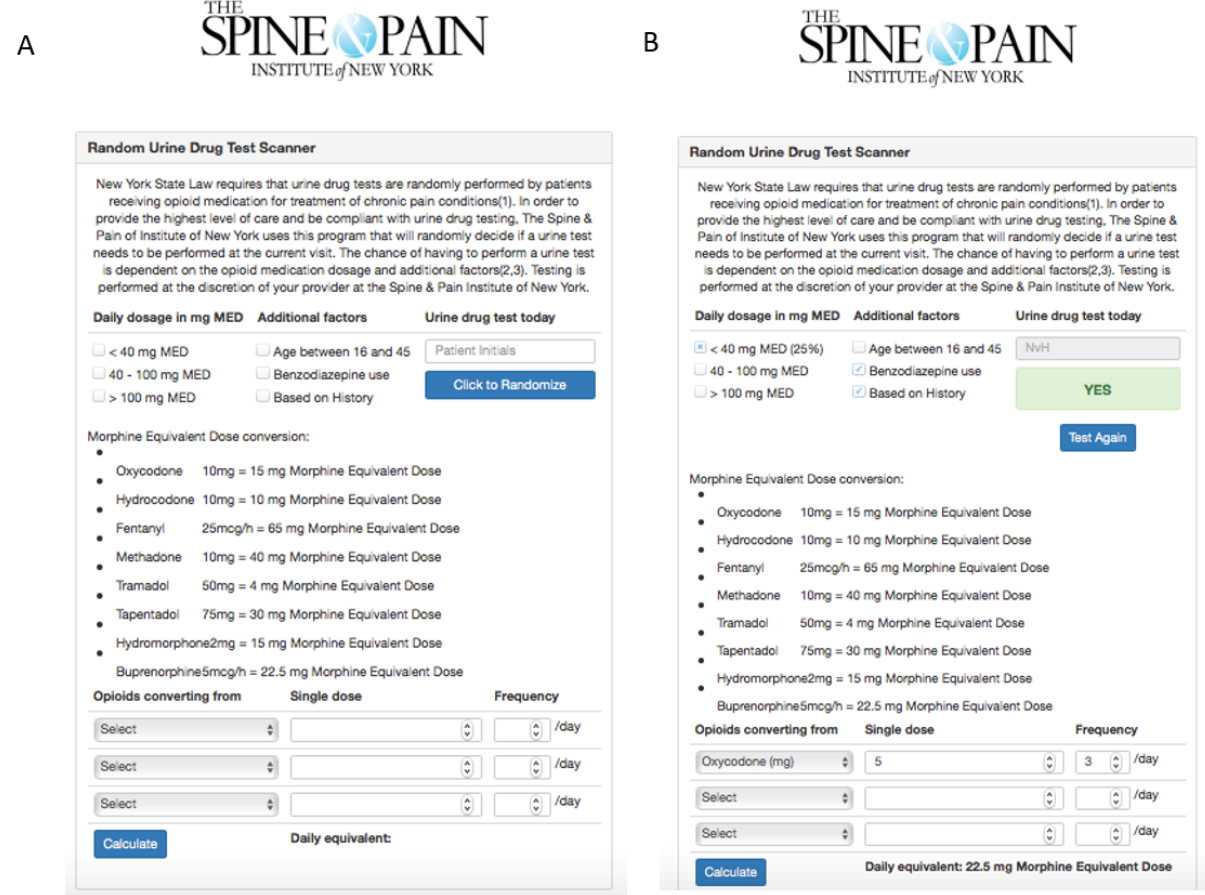
Figure 1. Screenshots of the UDT Randomizer tool prior to the selection of risk factors (A) and after the selection of risk factors (B). The recommendation to perform testing is “Yes” in this case.